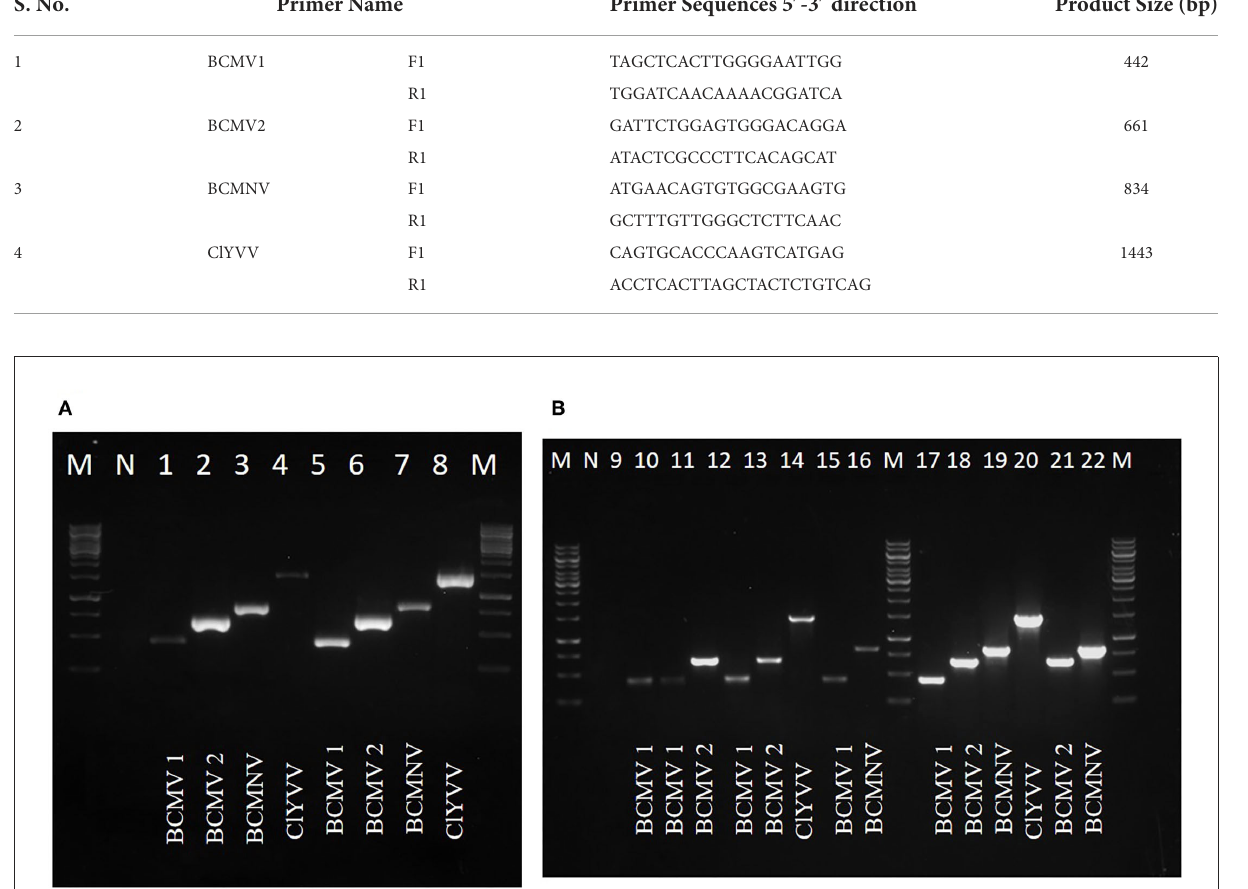
FIGURE3 RT-PCR confirmation of identified viruses by using newly designed virus-specific primers and (A,B) represents amplicons of identified viruses from lane 1 to 22, BCMV 1 (442bp), BCMV 2 (661bp), BCMNV (834bp), and ClYVV (1442bp). M is 1Kb molecular marker. N is the negative control of the healthy